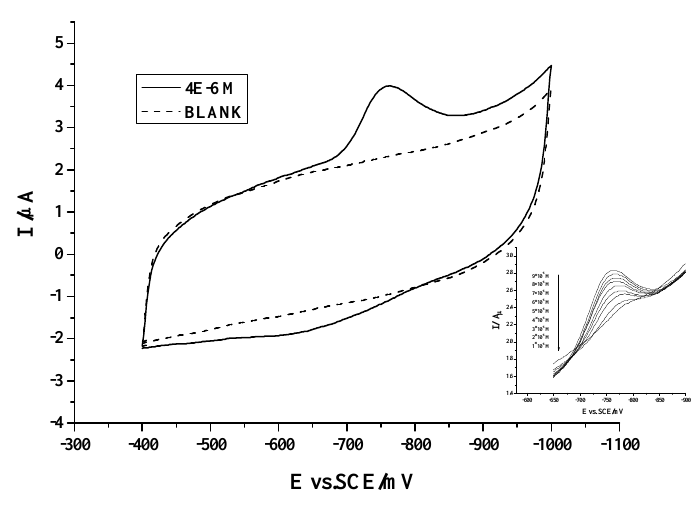
Figure 1. Cyclic voltammogram of camptothecin obtained at a PG electrode in 0.1 M Britton- Robinson buffer solution with pH 4.0 (The first scan). Scan rate: 100 mV s -1 . Accumulation time: 60 s. Inset is the cyclic voltammograms of camptothecin solutions with different concentrations.